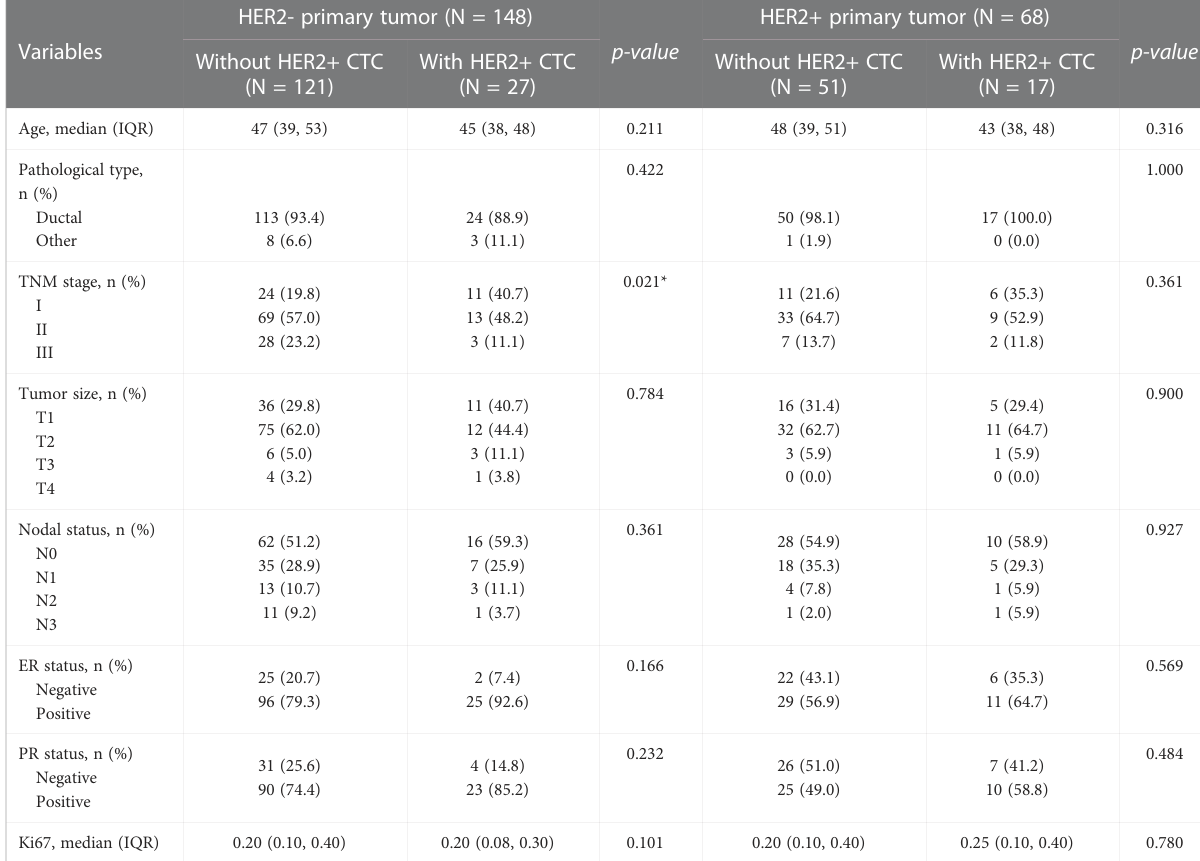
TABLE 2 Association between clinicopathologic parameters and HER2+ circulating tumor cells status.